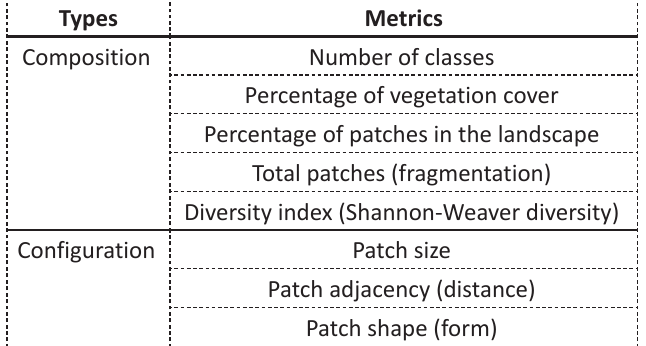
Table 1: Types of metrics chosen